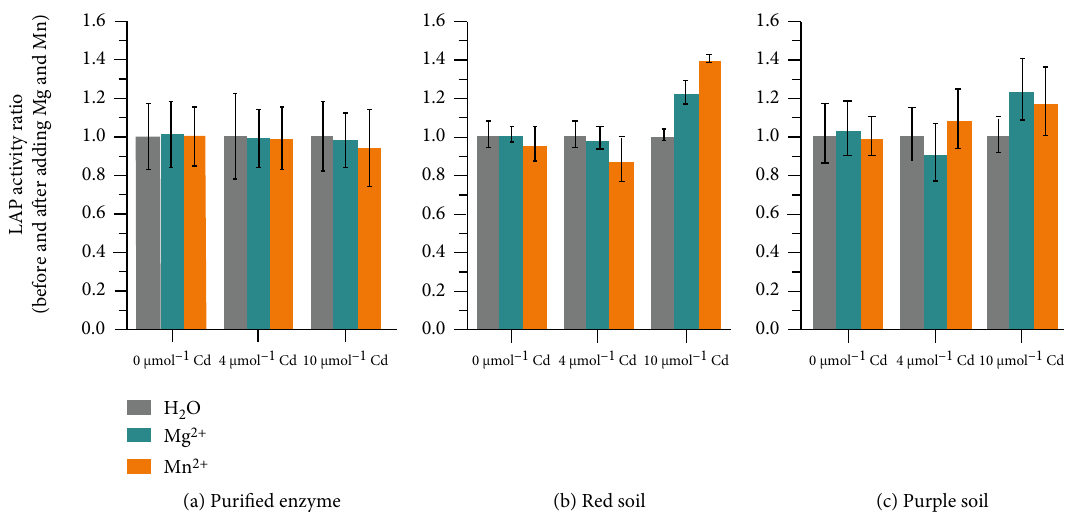
Figure 3: Proportion of change in the activity of Cd-contaminated LAP after the addition of Mg and Mn as restorative activators of LAP.